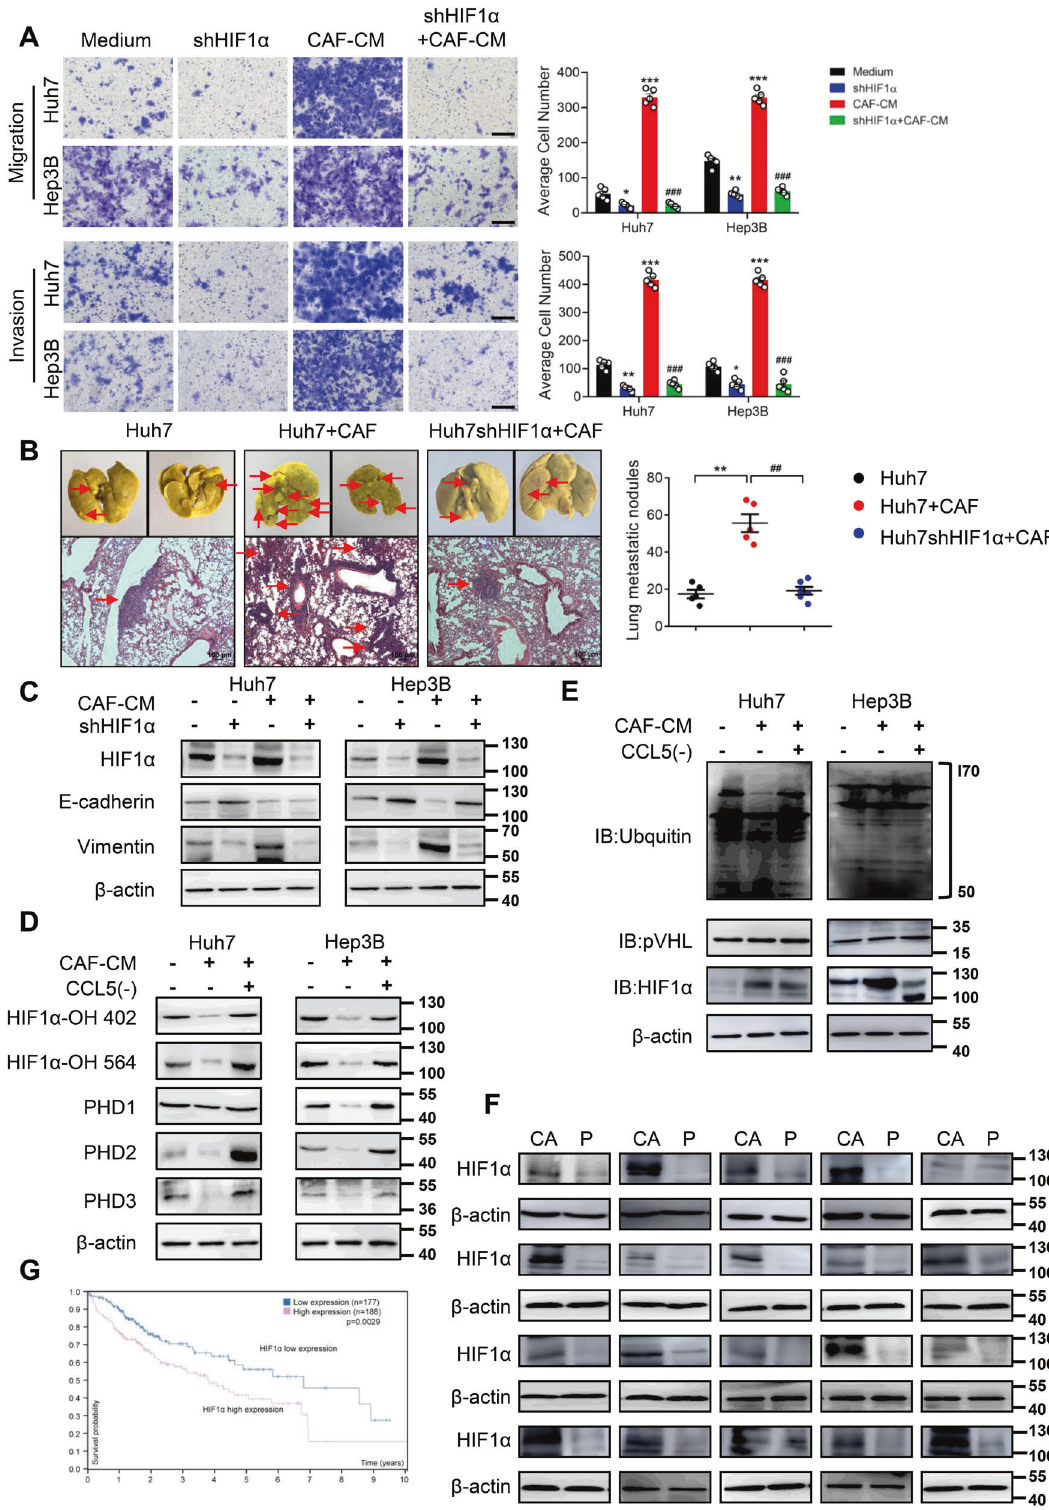
CAFs had an important impact on the progression of HCC in the tumor microenvironment. It has been reported that CAFs do not exist independently around tumors, but interact with tumor cells to promote their Cell Death and Disease (2022)